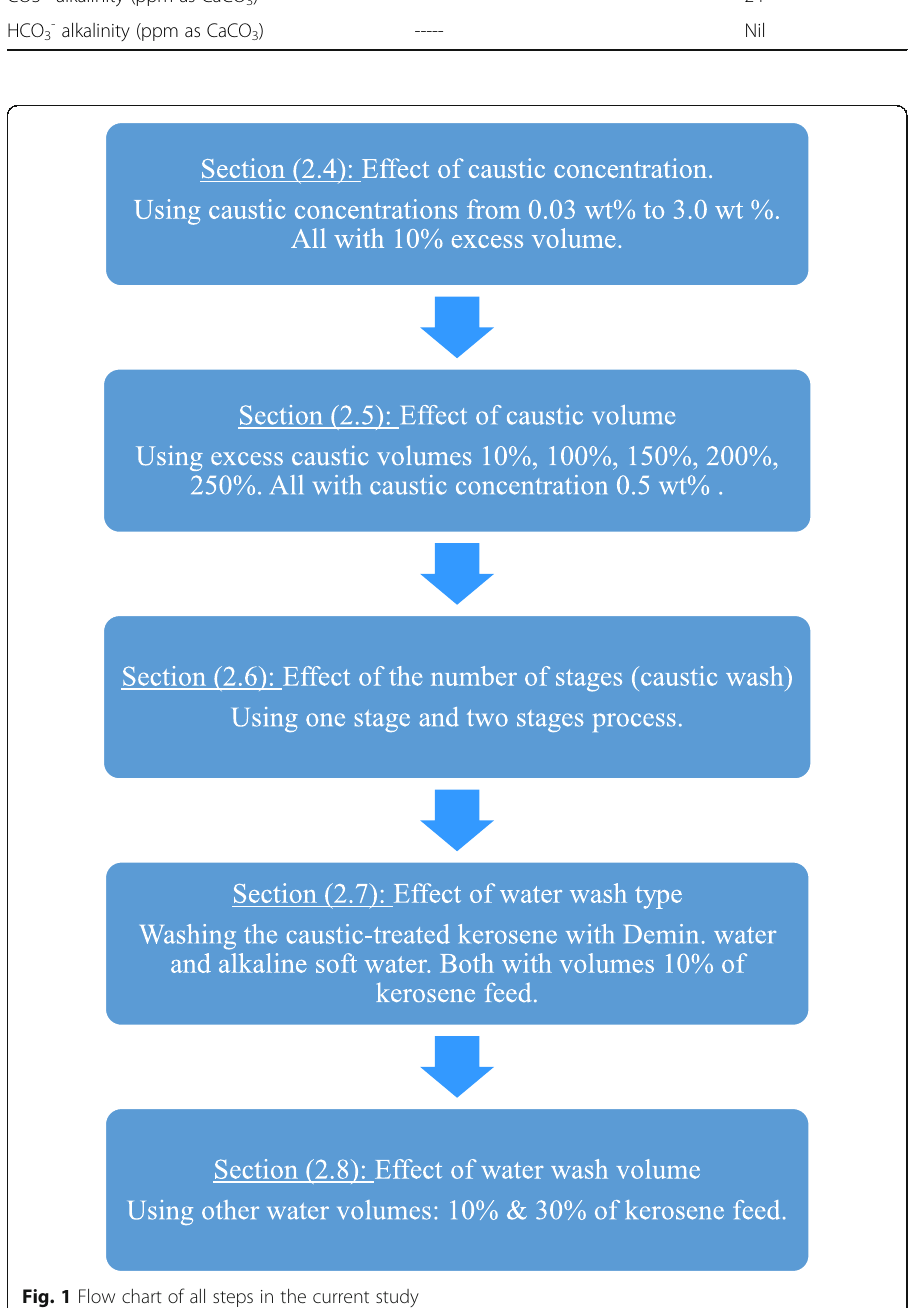
Fig. 1 Flow chart of all steps in the current